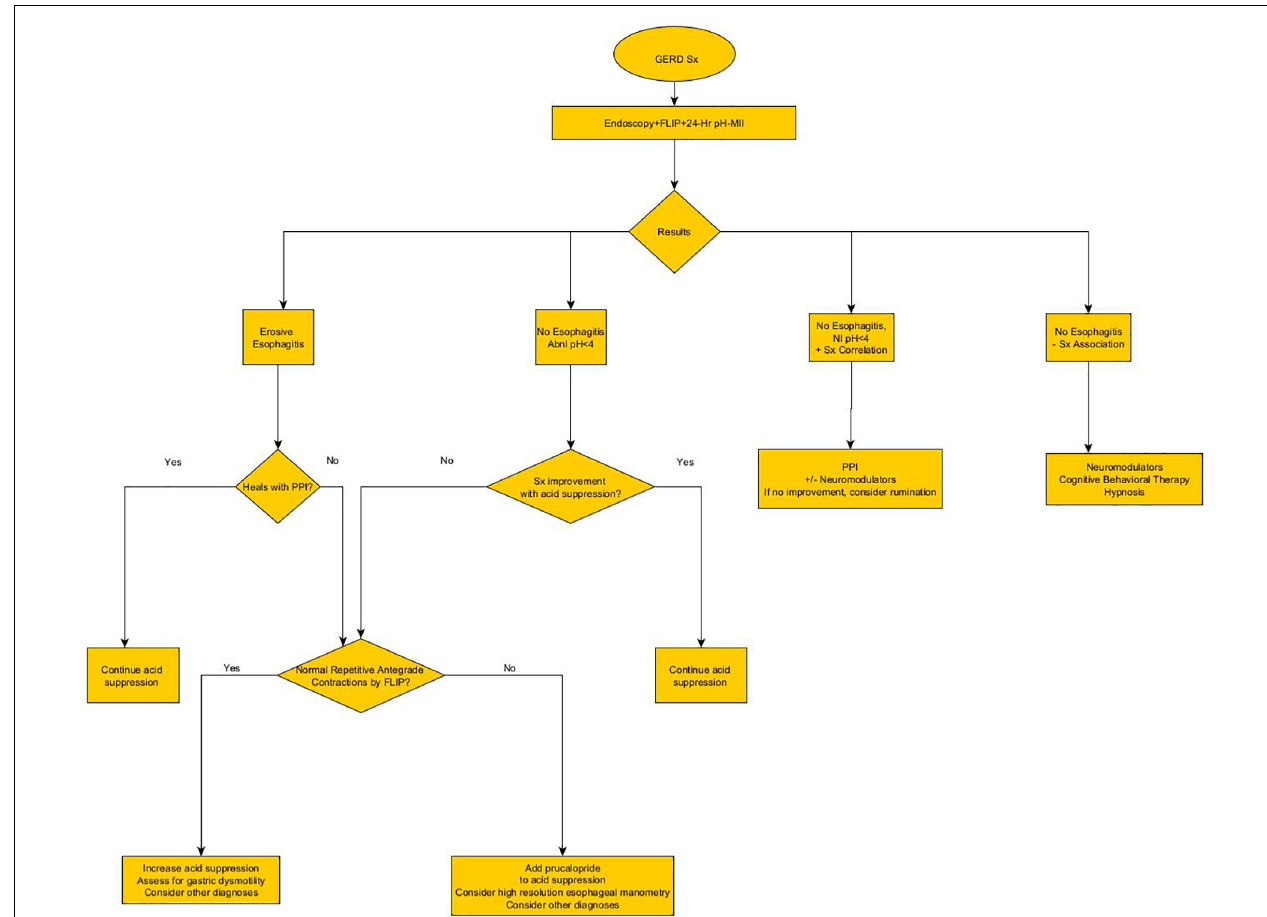
FIGURE 2 | Proposed future algorithm for the diagnosis and treatment of pediatric reflux, incorporating novel technology at the time of the index